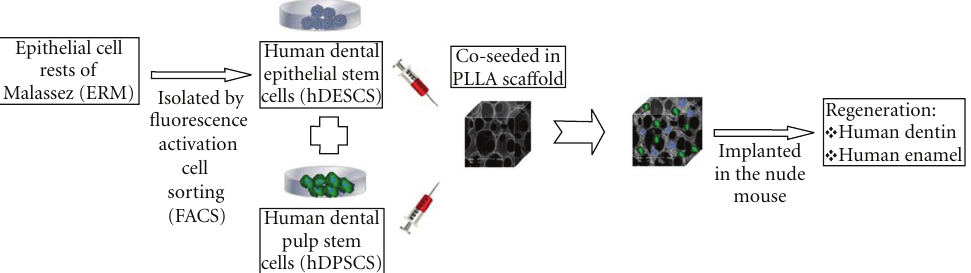
Figure 3: Layout of a cell-based strategy for the development of complex-like mineralized tissue by the co-seeding of hDESC and hDPSC.